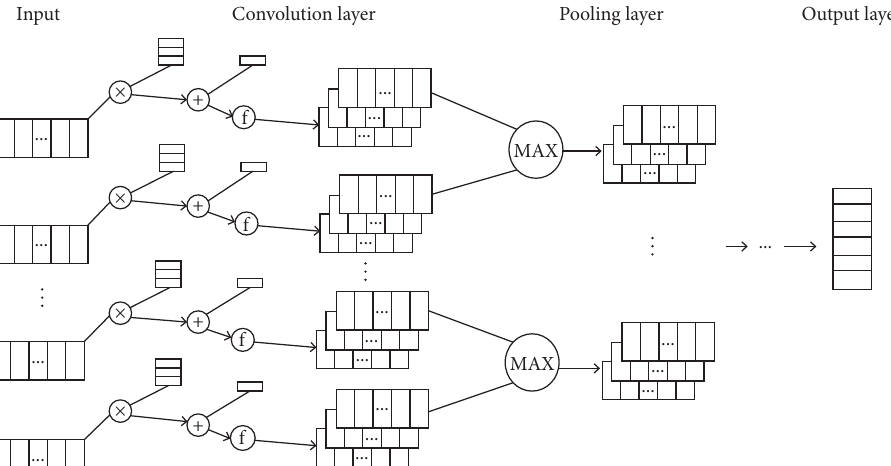
Figure 1: The typical structure of CNN.